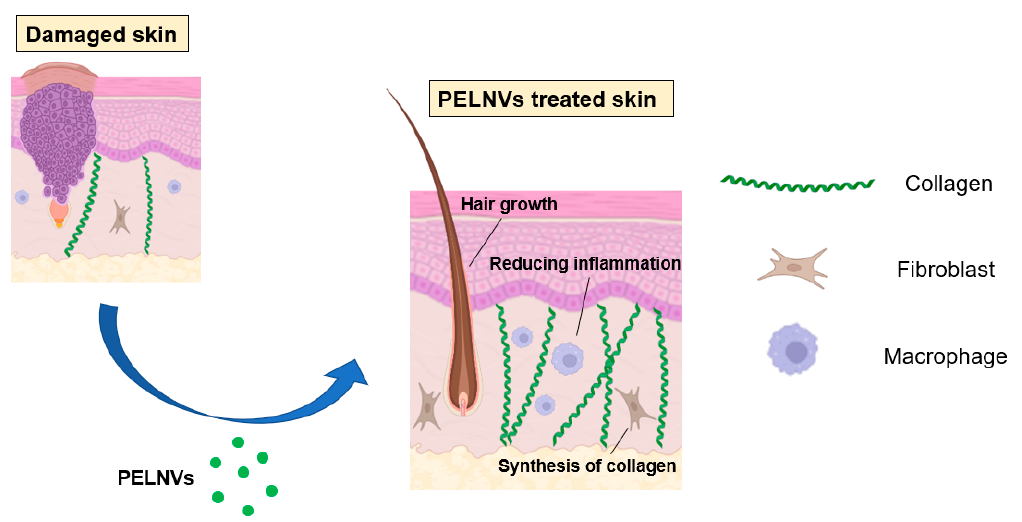
Figure 2. PELNVs used to repair the skin